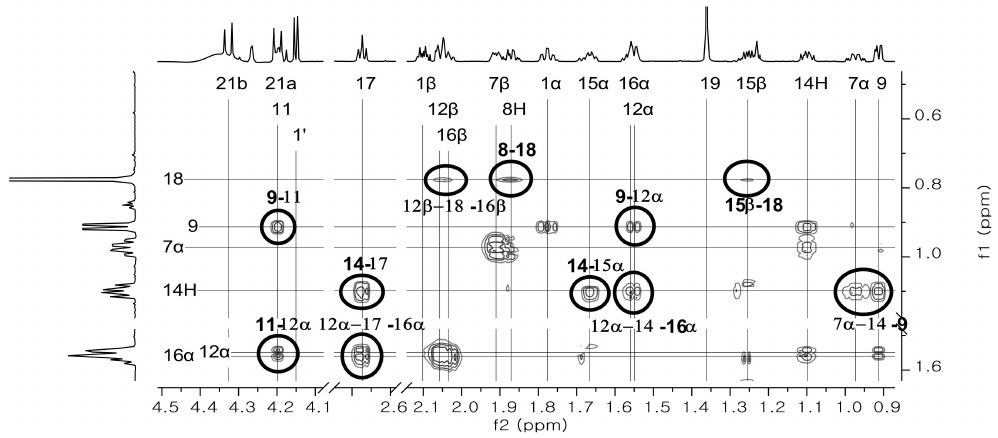
Figure 3. The partial ROESY spectra of corticosterone 21-glucoside for assignment of aglycone moiety H-12 and other hydrogens bound to a sterocenter. The cross peak in the circle concerned is a notable peak, and the numerical value at the side shows a position number of hydrogen at aglycone.